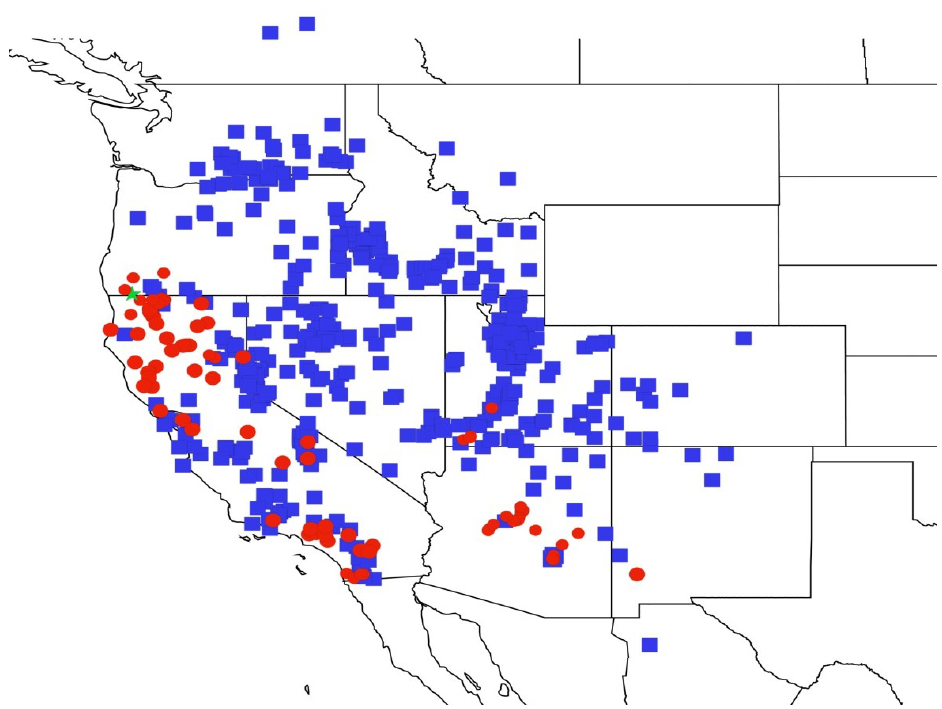
Figure 50. Distribution of Okanagana mariposa mariposa (red circles), O. mariposa oregonensis (green star) and O. utahensis (blue squares).